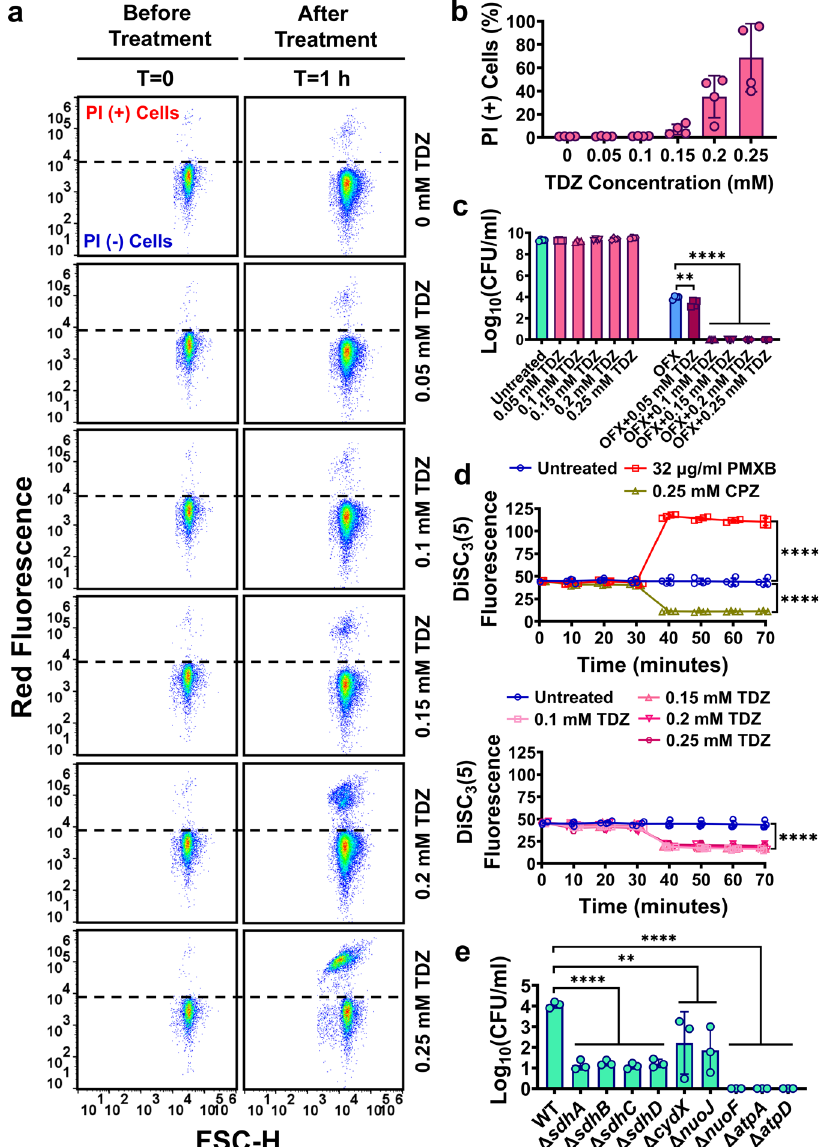
Fig. 8 Phenothiazines dissipate the proton concentration gradient across the membranes of exponential phase cells. a Phenothiazine-induced membrane permeabilization. Cells at exponential phase ( t = 3 h) grown in LB were treated with TDZ at indicated concentrations. Cells before and after 1 h treatment were stained with PI for fl ow cytometry analysis to quantify PI ( + ) cell fractions. Ethanol-treated dead cells and untreated live cells were used as positive and negative controls, respectively (see supplementary Fig. 8b). n = 4. b PI ( + ) cell fractions (%) in TDZ-treated cell cultures. n = 4. c Persister enumeration. Cells at exponential phase ( t = 3 h) were treated with OFX (5 µ g/ml) and/or phenothiazines at indicated concentrations. After the 20 h treatment, cells were plated for viable cell counts. n = 4. d DiSC 3 (5) assay. Metabolically active cells from exponential phase cultures ( t = 3 h) were transferred to a buffer solution containing 1 µ M DiSC 3 (5) (see Methods). When the cells reached equilibrium, they were treated with chemicals (CPZ, TDZ, or polymyxin B) at indicated concentrations. At designated time points, samples were collected, and fl uorescence levels were measured with a plate reader. Of note, the untreated control data is the same in both panels. Statistical analysis was performed between the fi nal time points of control and treatment groups. n = 4. e Persister levels of E. coli MG1655 mutant strains. Mutant cells at exponential phase ( t = 3 h) grown in LB were treated with OFX (5 µ g/ml) for 20 h. After a 20 h treatment, cells were plated for persister enumeration. n = 3. Statistical analysis was performed using one-way ANOVA